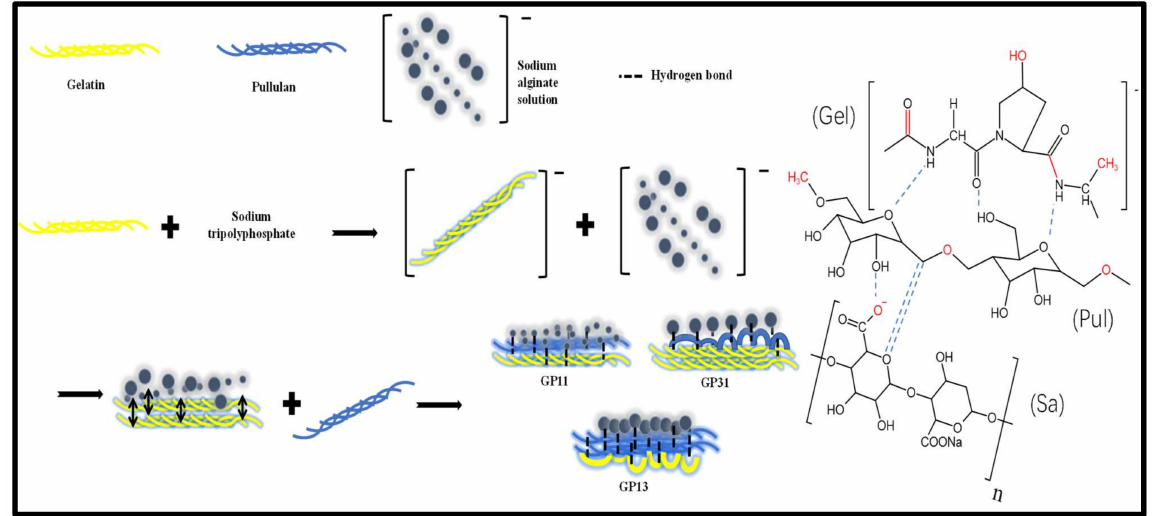
Figure 3. Interaction of pullulan with sodium alginate–gelatin-based films (Schematic diagram of film formation mechanism, Pul: Pullulan, Gel: Gelatin, Sa: Sodium